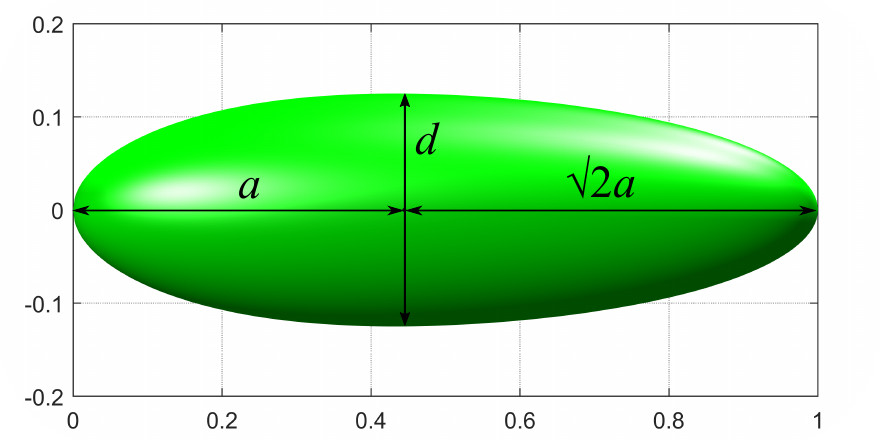
Figure 9. NPL—the low drag